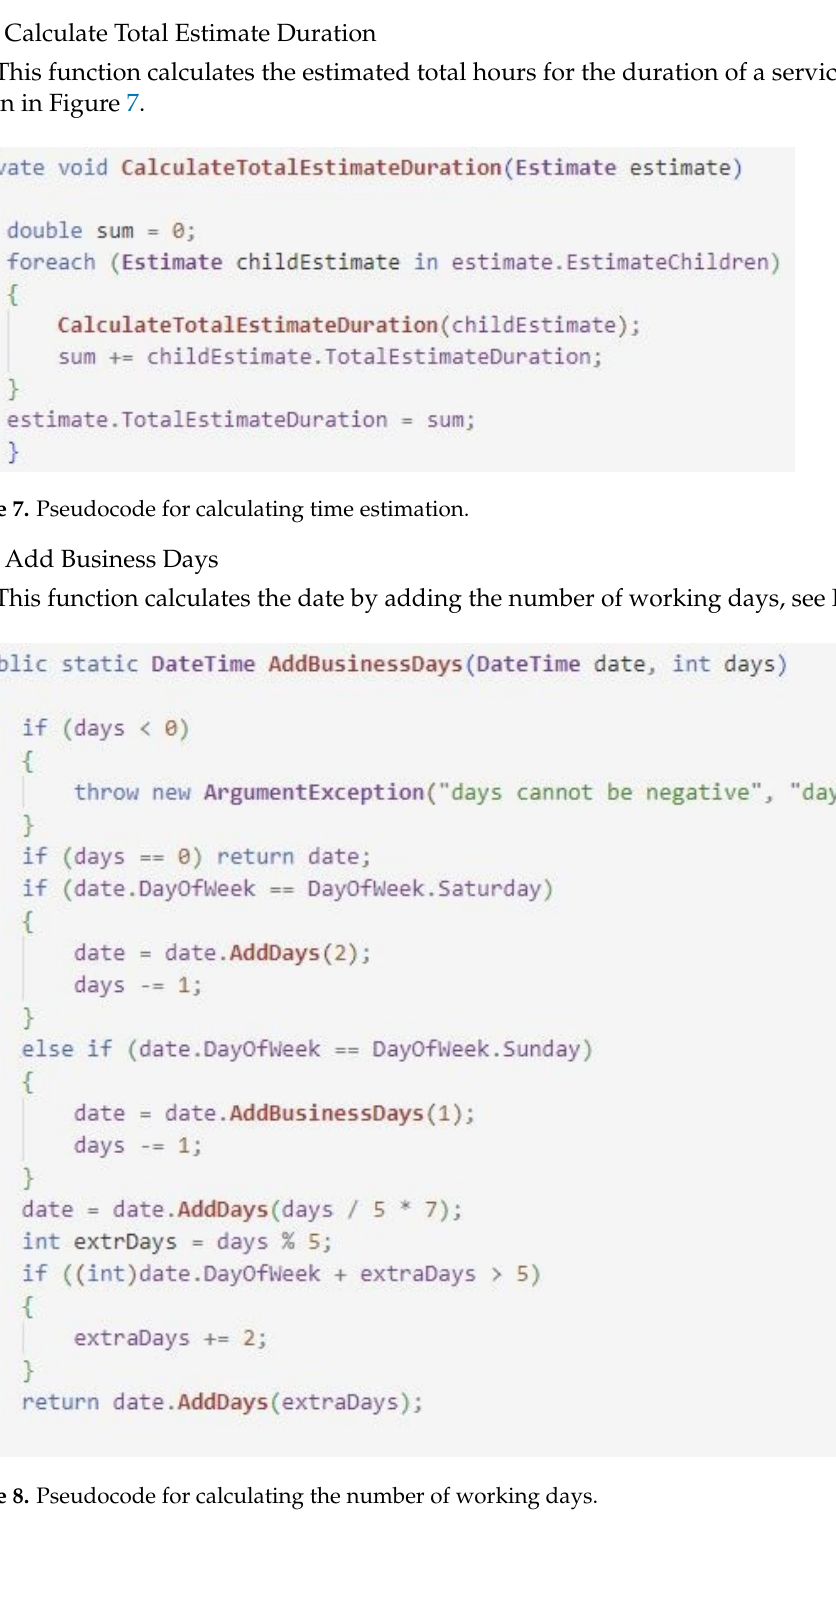
Figure 6. Pseudocode for calculating the duration in hours.